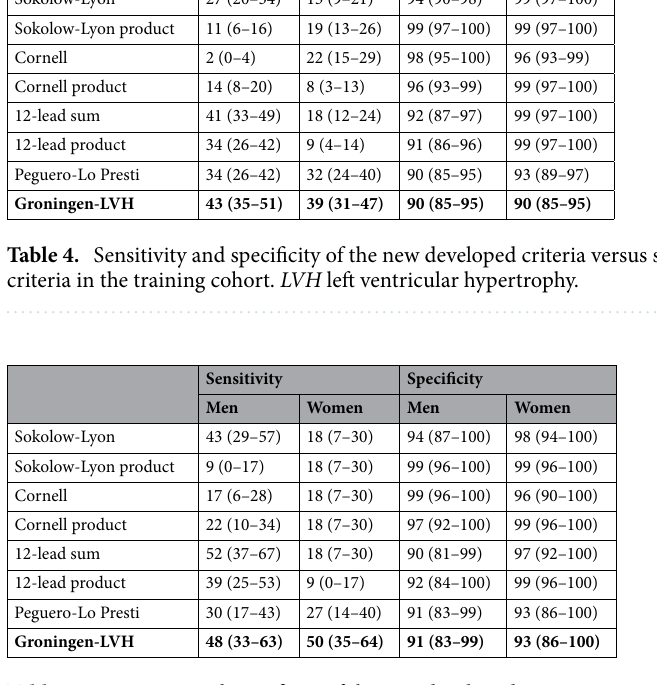
Table 5. Sensitivity and specificity of the new developed criteria versus sensitivity and specificity of existing criteria in the validation cohort. LVH left ventricular hypertrophy.